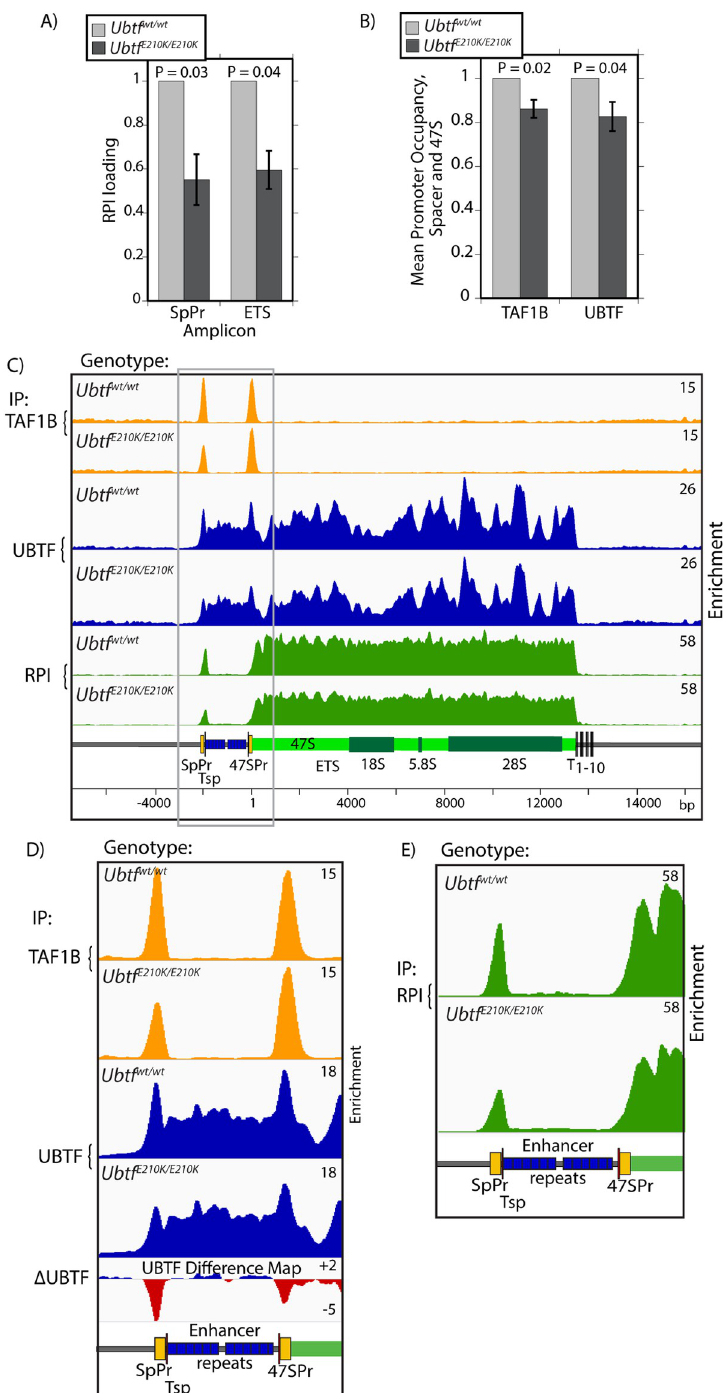
Fig 7. The E210K mutation in UBTF suppresses both the RPI loading across the rDNA and preinitiation complex formation at the Spacer and 47S promoters. A) ChIP-qPCR analysis of RPI occupancy at the Spacer promoter within the ETS region of the 47S coding region in Ubtf E210K/E210K and wild type MEFs. B) ChIP-qPCR analysis of relative preinitiation complex formation in Ubtf E210K/E210K and wild type MEFs. The data show the mean occupancy at amplicons SpPr and T0/Pr by TAF1B or UBTF. The data in A and B derive from 4 independent ChIP-qPCR experiments and error bars indicate the SEM, see Fig 2A and Materials and Methods for amplicon positions. C), D) and E) DChIP-Seq mapping of TAF1B, UBTF and RPI across the rDNA of Ubtf E210K/E210K and wild type MEFs.